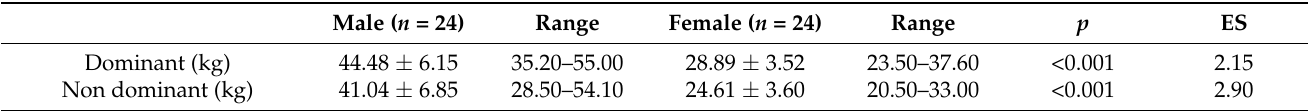
Table 3. Maximum hand grip